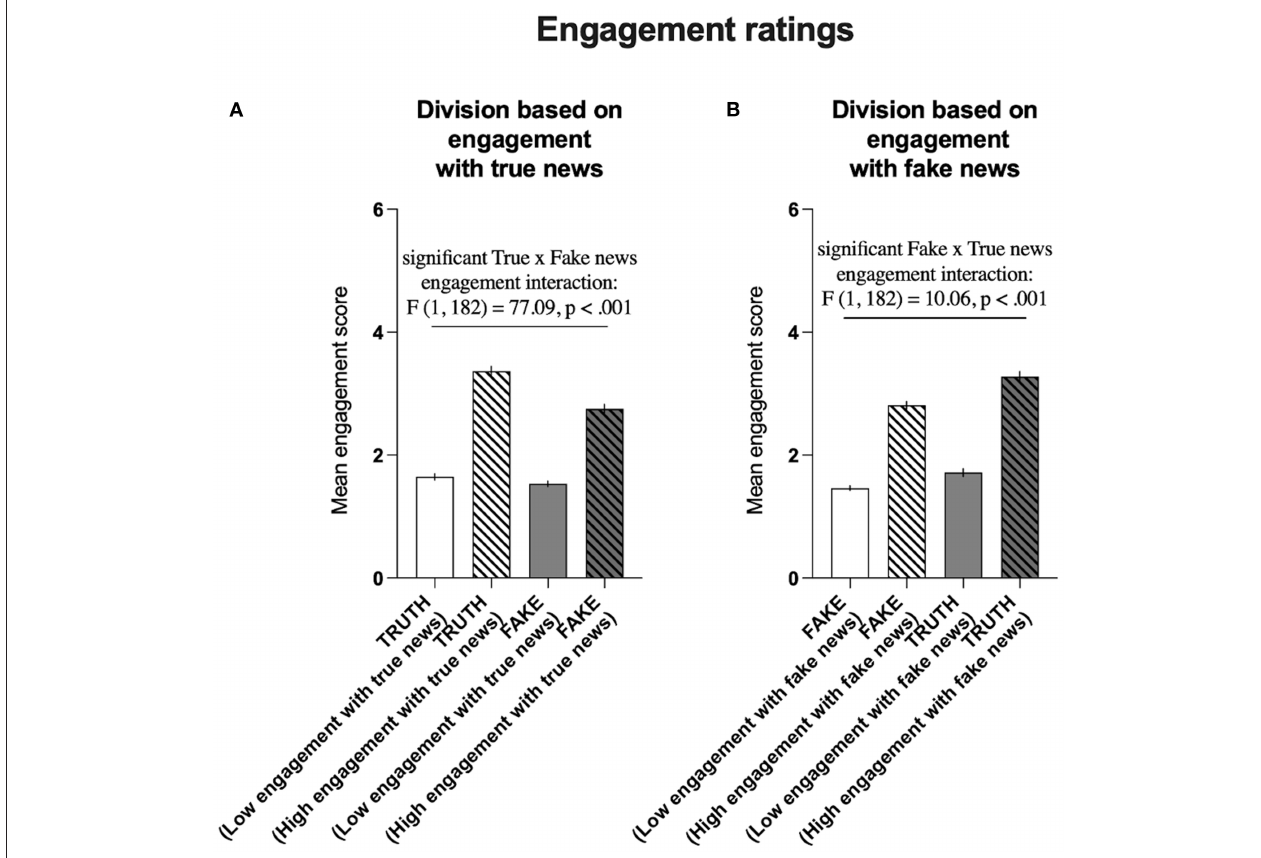
FIGURE 9 | Division based on declared engagement with true and fake news. (A) Comparison of the declared average engagement with true news ( ) with the average declared engagement with fake news ( ) in groups that were differentiated based on the average low ( N = 94) and high ( N = 90) declared engagement with true news ( ). (B) Comparison of the average declared engagement with fake news ( ) with the average declared engagement with true news ( ) in groups that were differentiated based on the average low ( N = 93) and high ( N = 91) engagement with fake news ( ). The data are presented as AVG engagement ratings ±